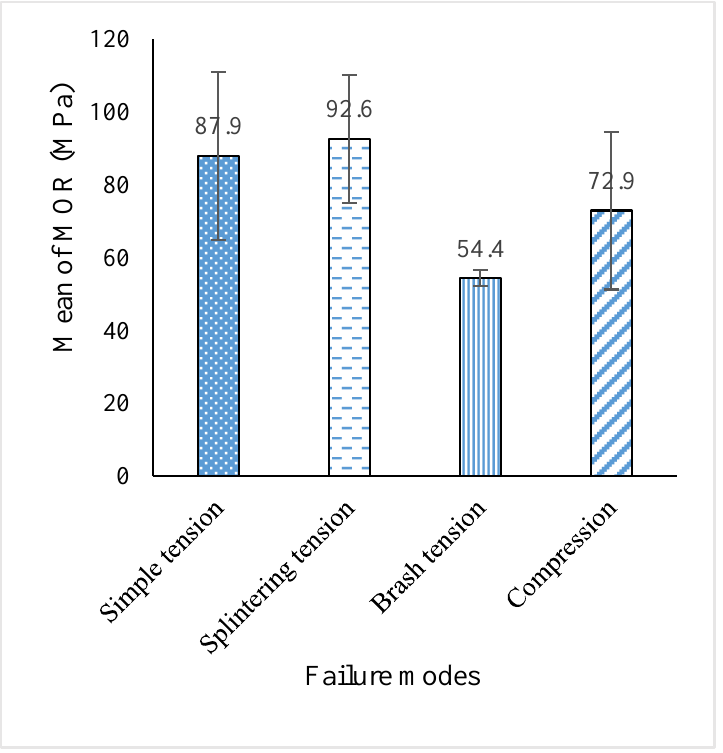
Figure 5. Average modulus of rupture (MOR) of Eucalyptus urograndis wood corresponding to types of failure.